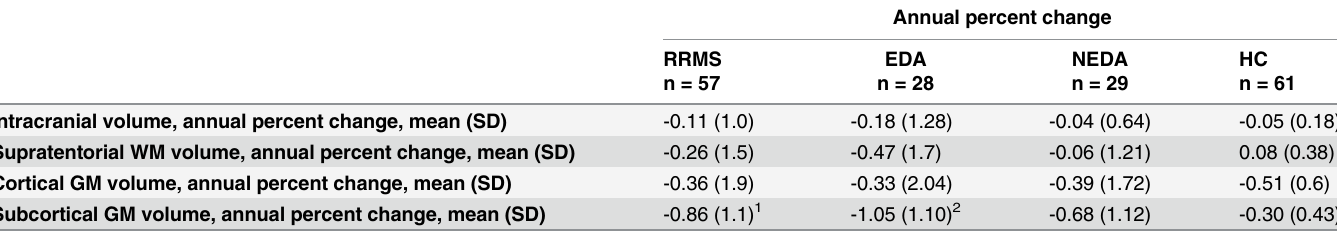
Table 4. Annual percent change of MRI volumes of patients and controls.